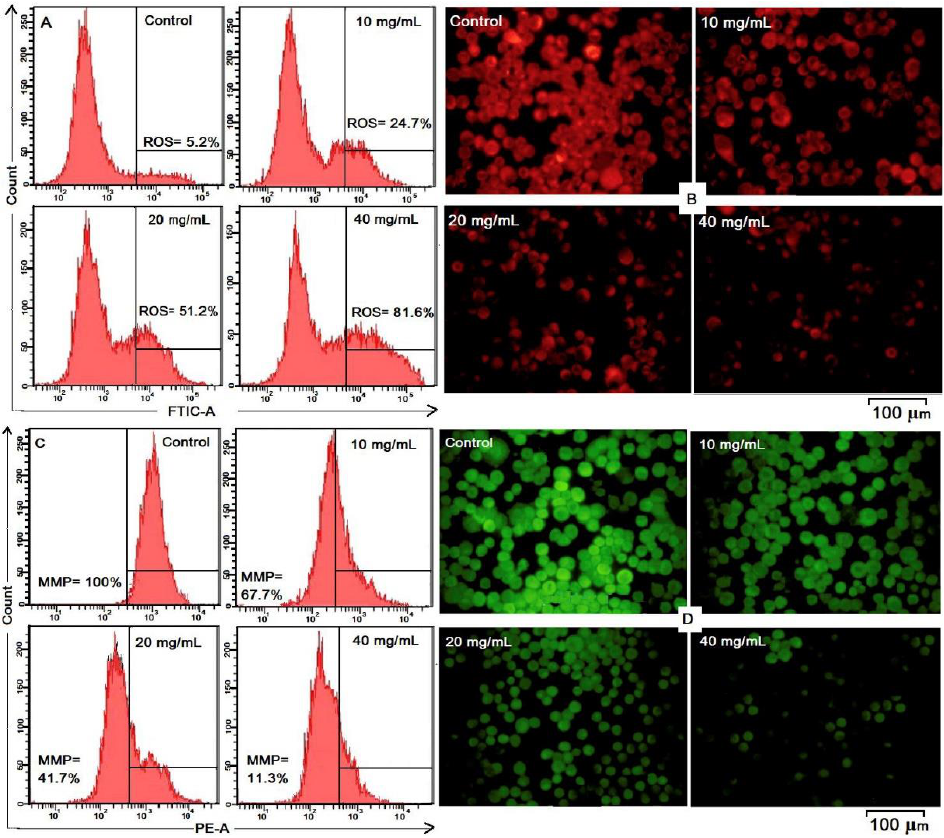
Figure 11. Measurements of ( A ) ROS generation and ( C ) MMP induced by various concentrations (10 – 40 µg·mL – 1 ) of SeNPs using flow cytometry; ( B , D ) microscopy illustration of ROS and MMP production, respectively. Reproduced with permission from Ref.[285]. 2020, Elsevier.